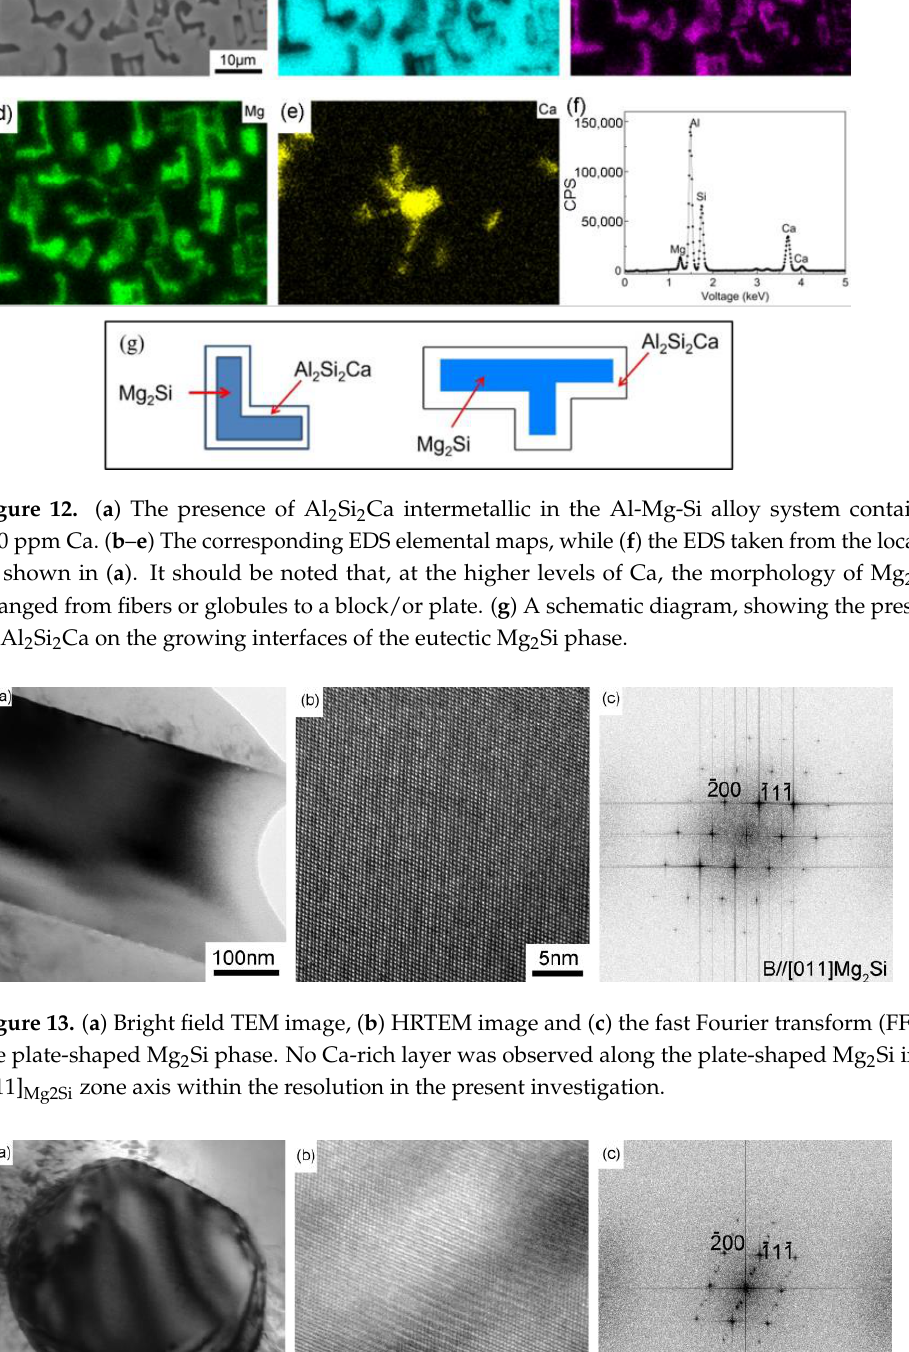
Figure 14. ( a ) Bright field TEM image, ( b ) HRTEM image and ( c ) FFT of the globular-shape Mg 2 Si phase. No Ca-rich layer was observed along the globular-shaped Mg 2 Si in the [011] Mg2Si zone axis within the resolution in the present investigation.